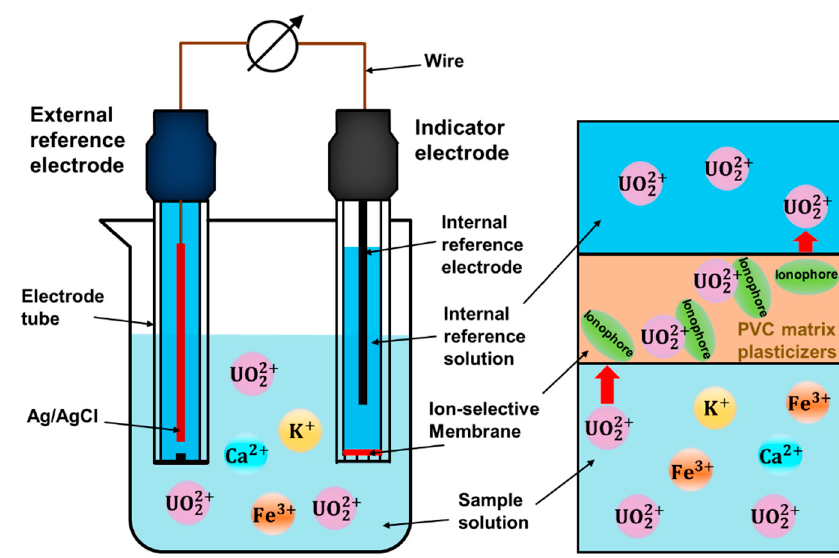
Figure 1. Membrane-Based Electrochemical Detection of Uranium.